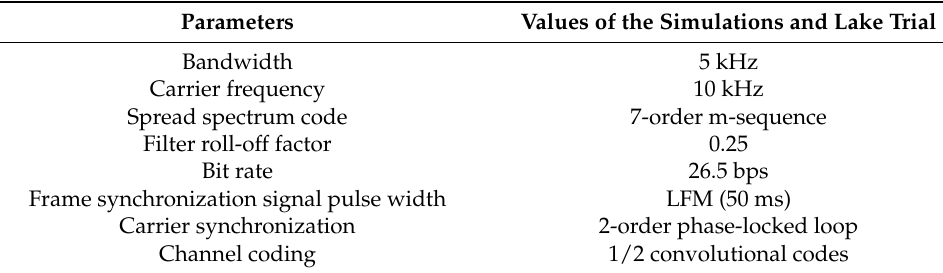
Table 1. The parameter settings of DS-CDMA in the simulations and lake trial.